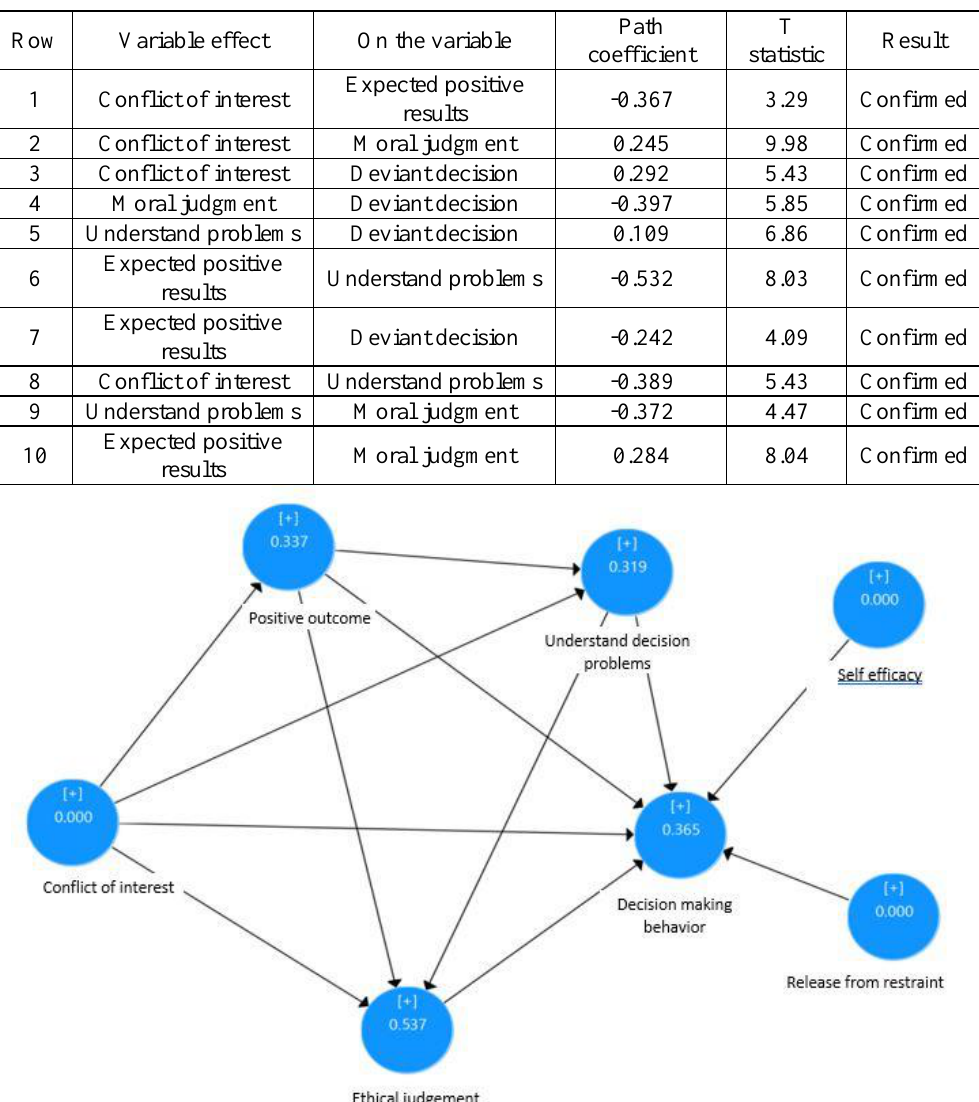
Model 3. Graphic model of research (representing cv